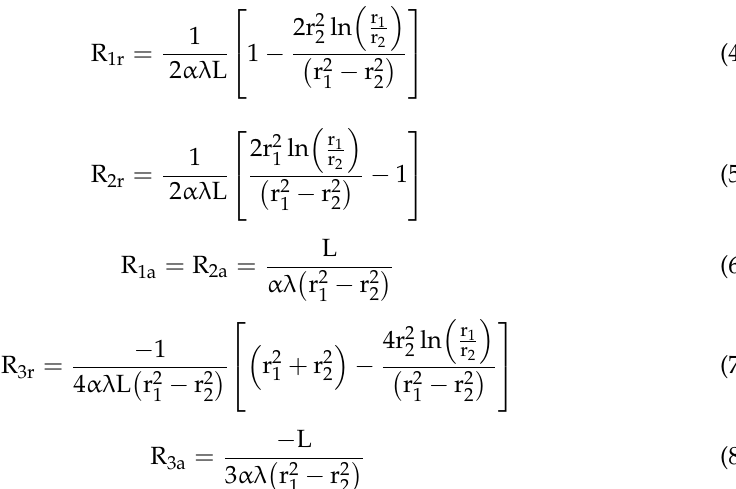
( a ) ( b ) Figure 15. ( a ) Cylindrical components in electrical machines with angular spans α and ( b ) its equiv- alent thermal network. T 1 , T 2 , T 3 and T 4 are the temperatures of the front, rear, outer and inner sur- faces, respectively.